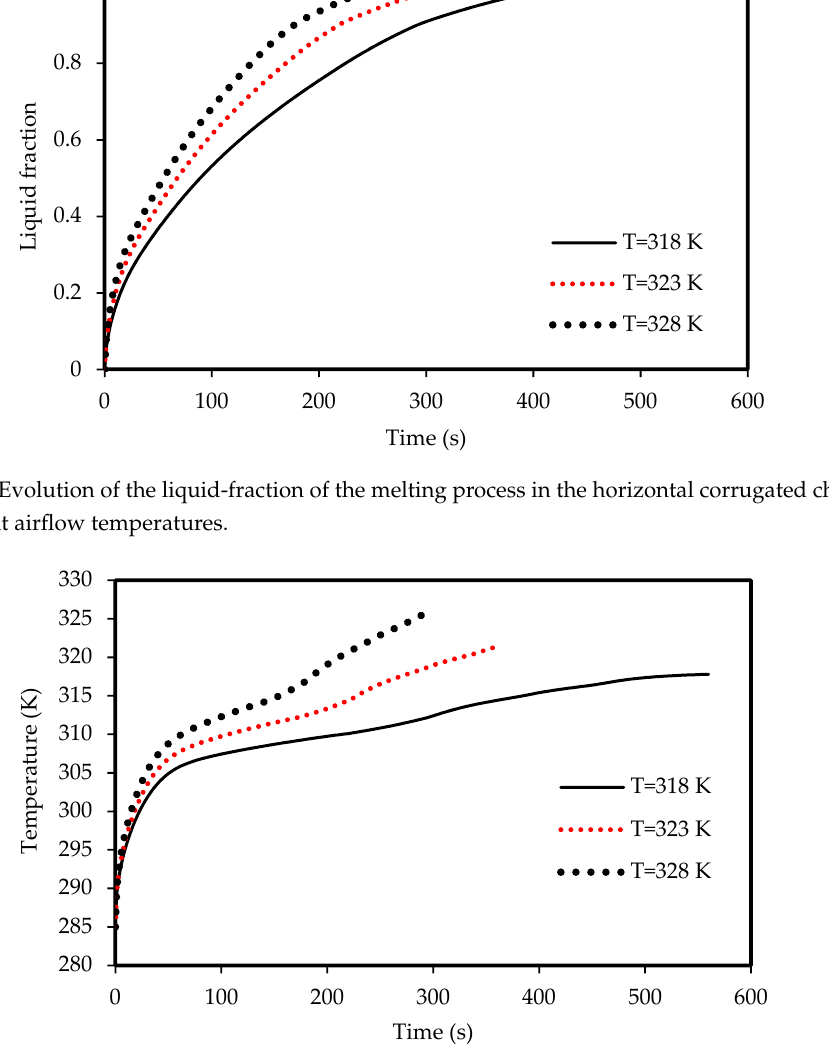
Figure 22. Variation of the temperatures for the melting process in the horizontal corrugated channel for different airflow temperatures.